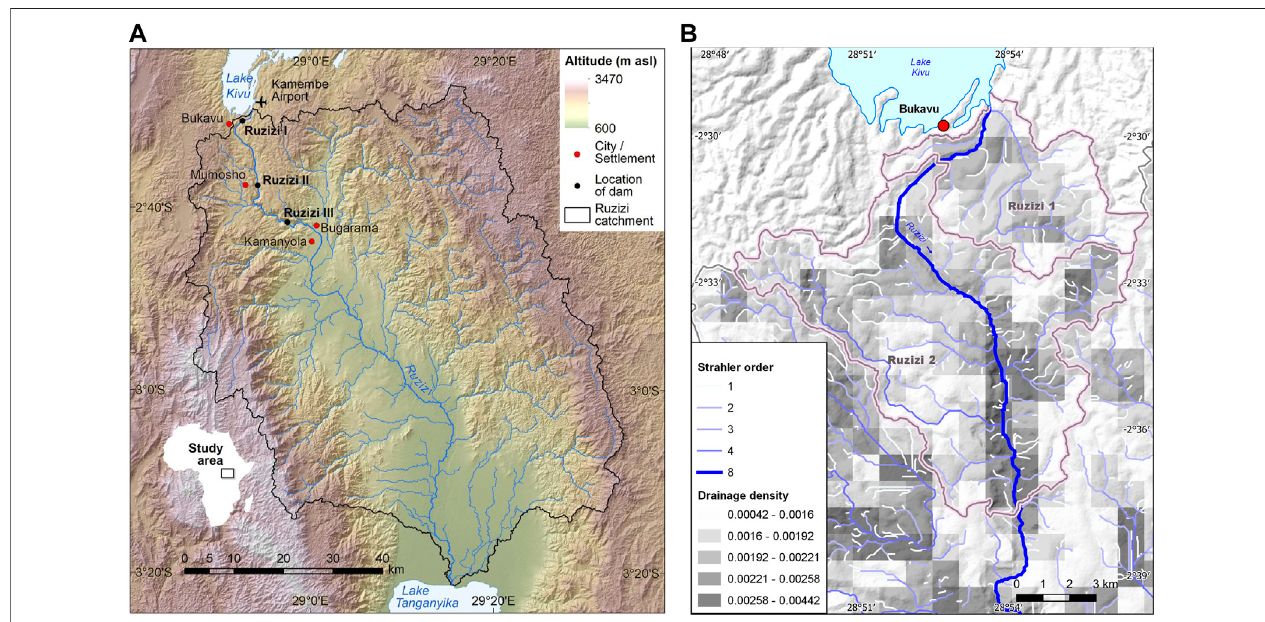
FIGURE1|(A) Map oftheRuzizi catchmentshowing hydropowerdam locations modi fi edafter Eisenberg(2018) (B) .Drainage density and the Strahler ordermap for the Ruzizi River catchment according to Strahler (1952).